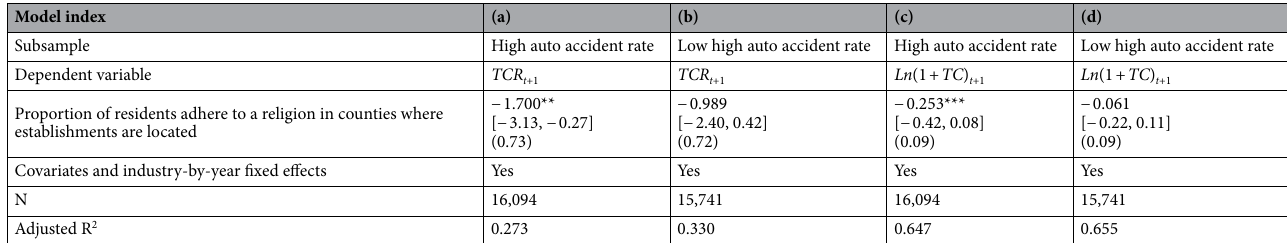
Table 6. The relationship between religiosity and workplace safety conditional on auto accident rate in the state where the establishment is located. Columns (a) and (b) display statistics from models that regressed each private-sector establishment’s Total Case Rate of injuries, illnesses, and deaths (TCR)—as recorded by the United States Occupational Safety and Health Administration (OSHA) 40 from 2002 to 2011—on its county’s proportion of residents acknowledging a religious affiliation 30,33,34 in the subsample where the state-level Auto Accident Rate is above or equal to (a) or below (b) the sample median in a year, where Auto Accident Rate is the “fatality rate per 100 million vehicle miles traveled”, as defined by Unites States Department of Transportation 46 . Columns (c) and (d) report regressions of the natural logarithm of one plus Total Cases of injuries, illnesses, and deaths (TC) 40 on those same variables. All coefficient estimates and associated statistics appear in the supplementary information, but we display the estimate for the focal coefficient—proportion of county population adhere to a religion—in the fourth row of the table, respectively, following the model index, subsample indicator and the listing of the dependent variable used in each model. The fifth row indicates whether the model involved covariates and binary indicators signaling the industry-by-year of a given record for an establishment. The second to last row lists the number of observations (N) and the final row displays the proportion of explained variance (R 2 ), adjusted for covariates. Asterisks denote the level of p values: *** p < 0.01, ** p < 0.05, * p <